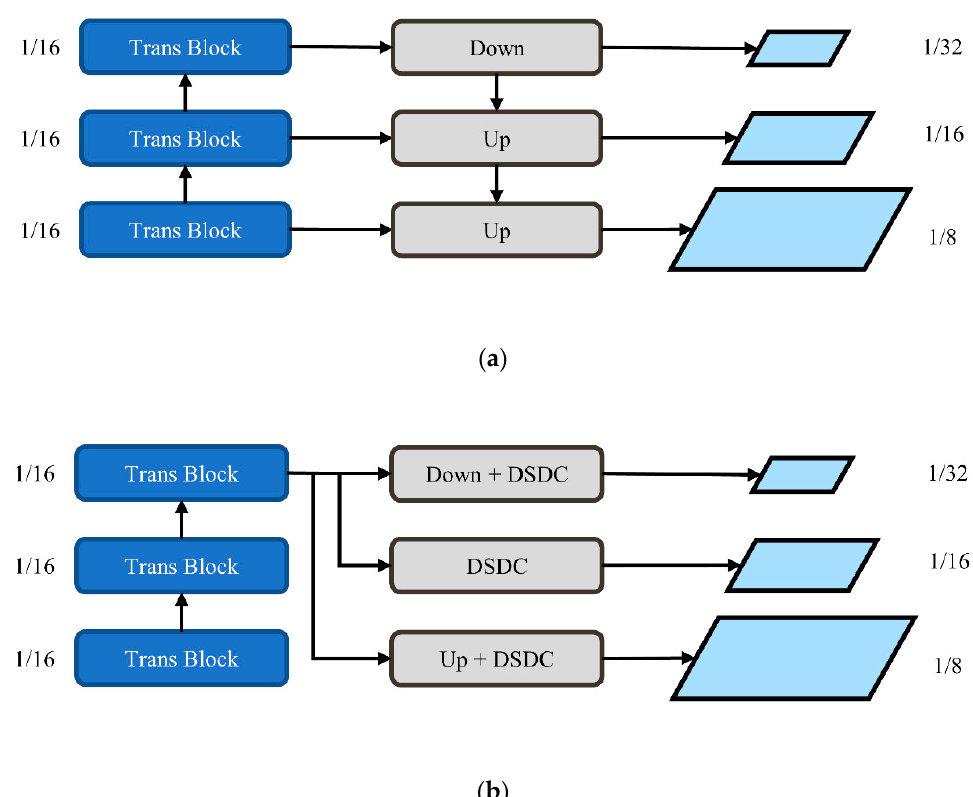
Figure 7. Comparison of feature pyramid network and depthwise separable deformable pyramid module: ( a ) FPN; ( b ) DSDC.